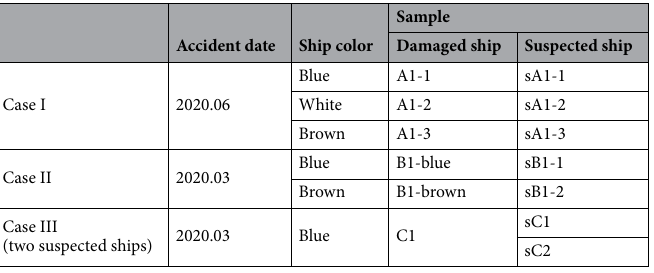
Table 1. Paint collected from the collision